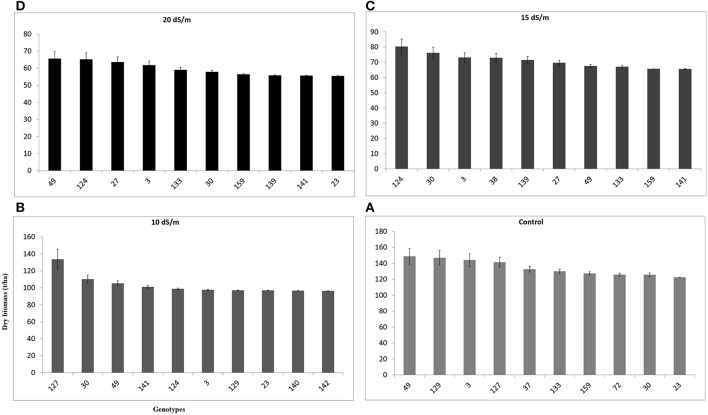
Effect of different irrigation water salinity levels on dry weight (total annual dry biomass) of TOP 10 Cenchrus ciliaris genotypes. Error bars represent standard deviations of the mean of four replicates. Whereas, (A) = 0, (B) = 10, (C) = 15, and (D) = 20 dS m™1 salinity level.